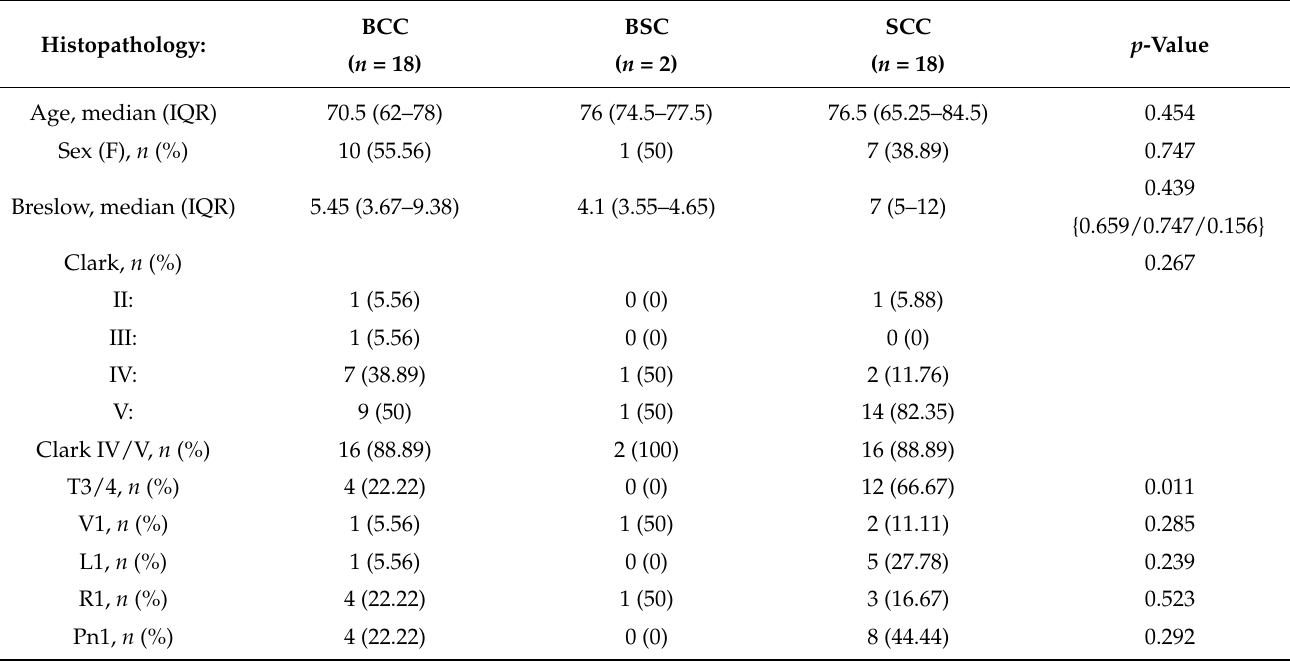
Table 2. Nonmelanoma skin cancer participants’ characteristics.